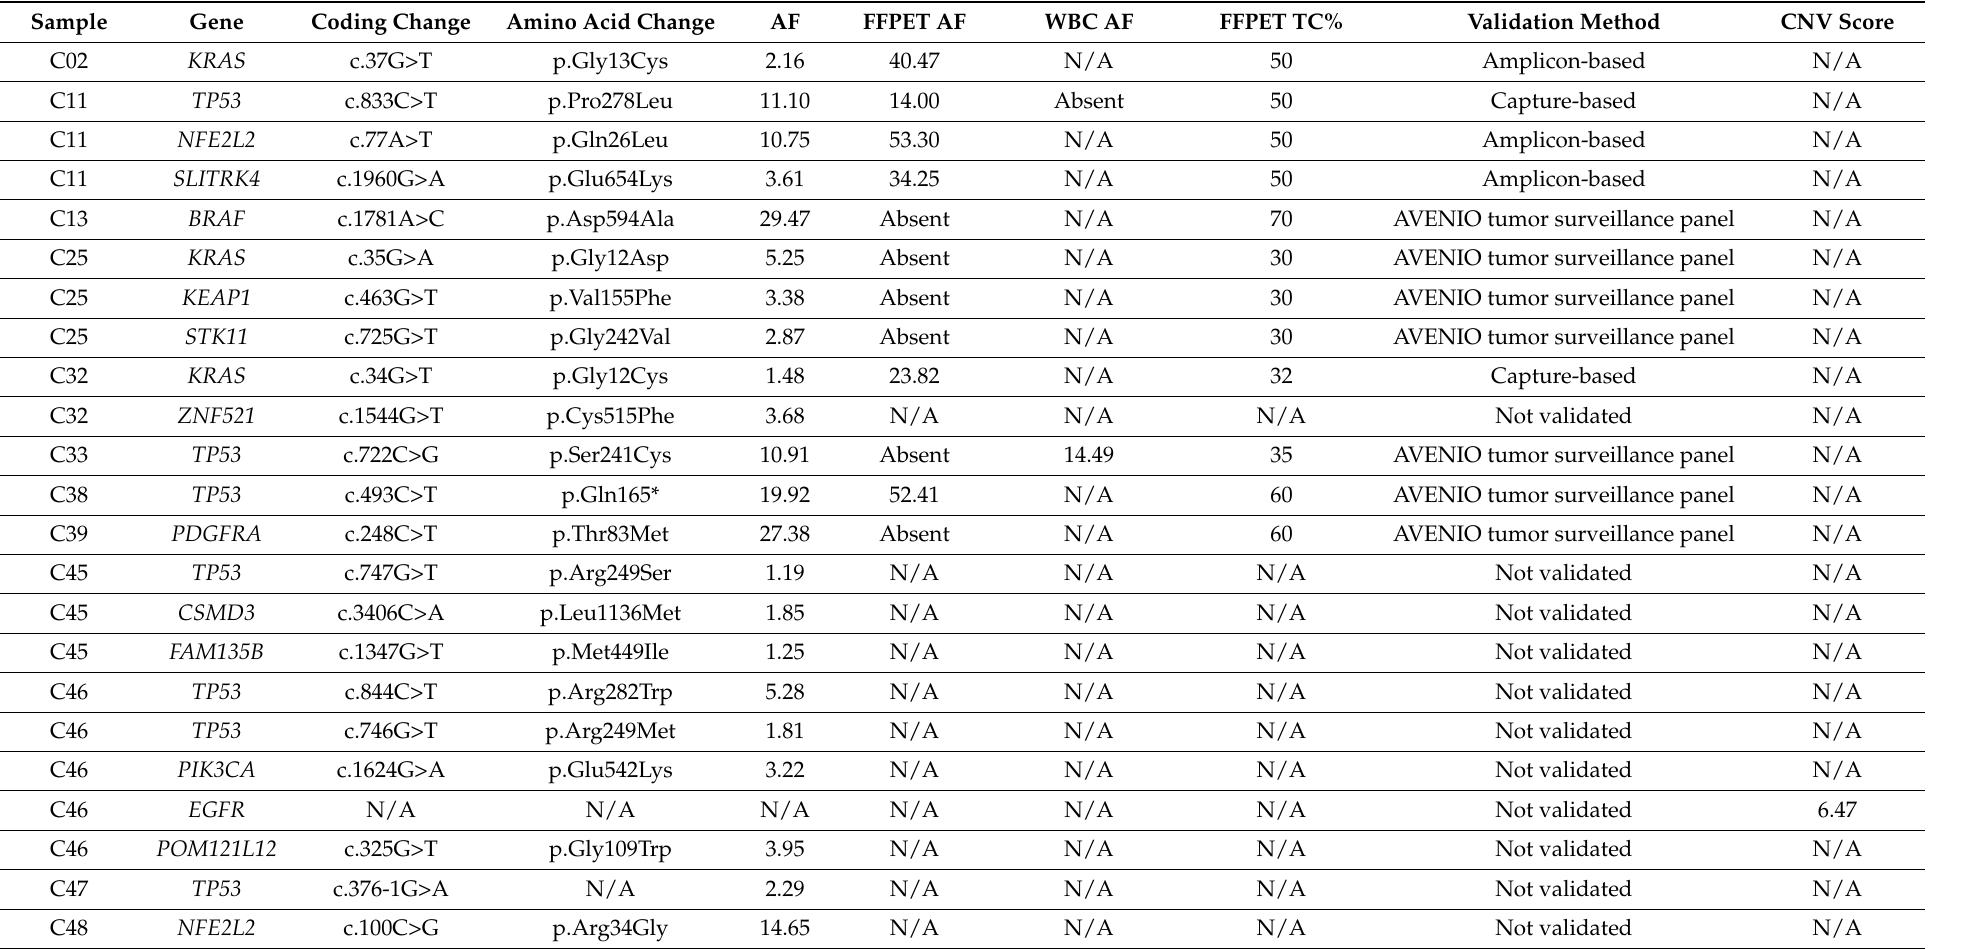
Table 2. Variant metrics of patient samples, custom